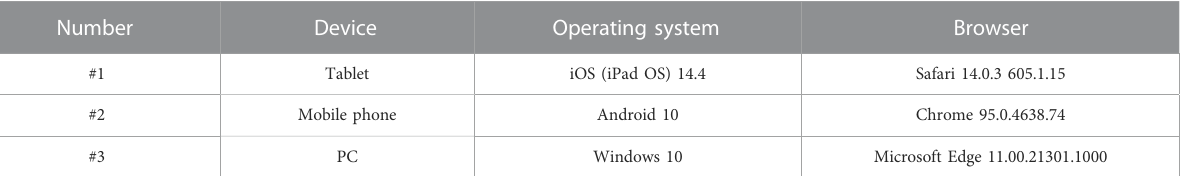
TABLE 3 Terminal environment for